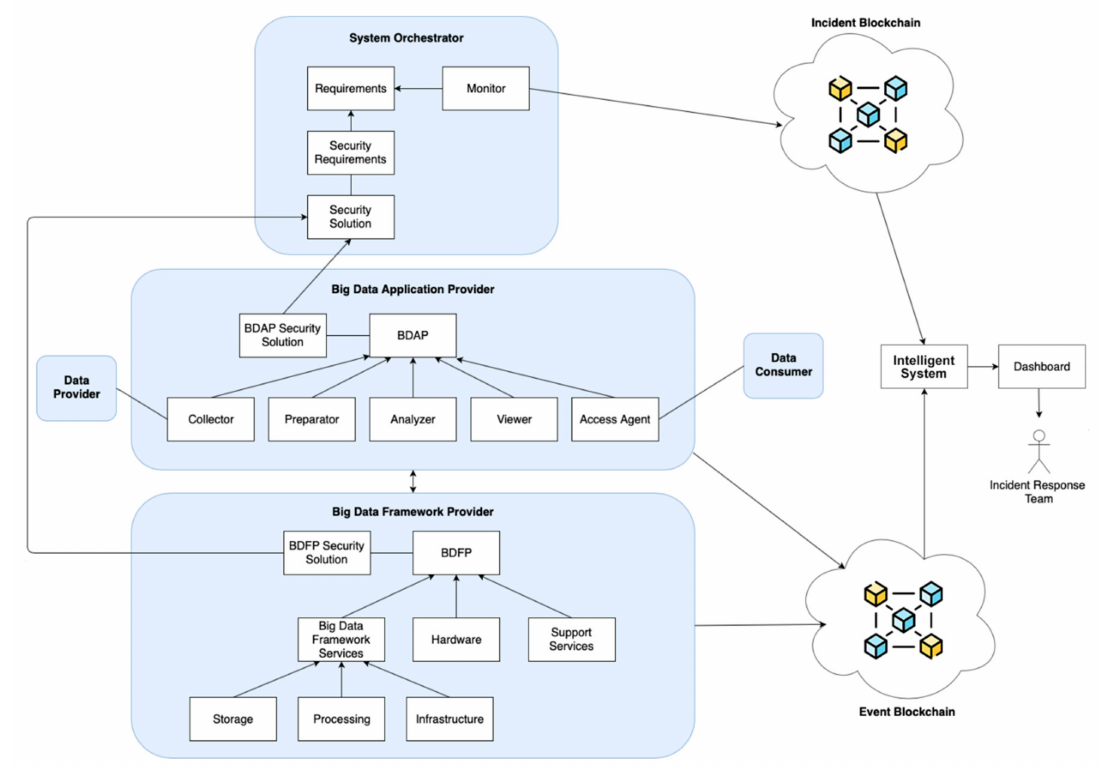
Figure 5. Interaction between big data ecosystems and blockchain